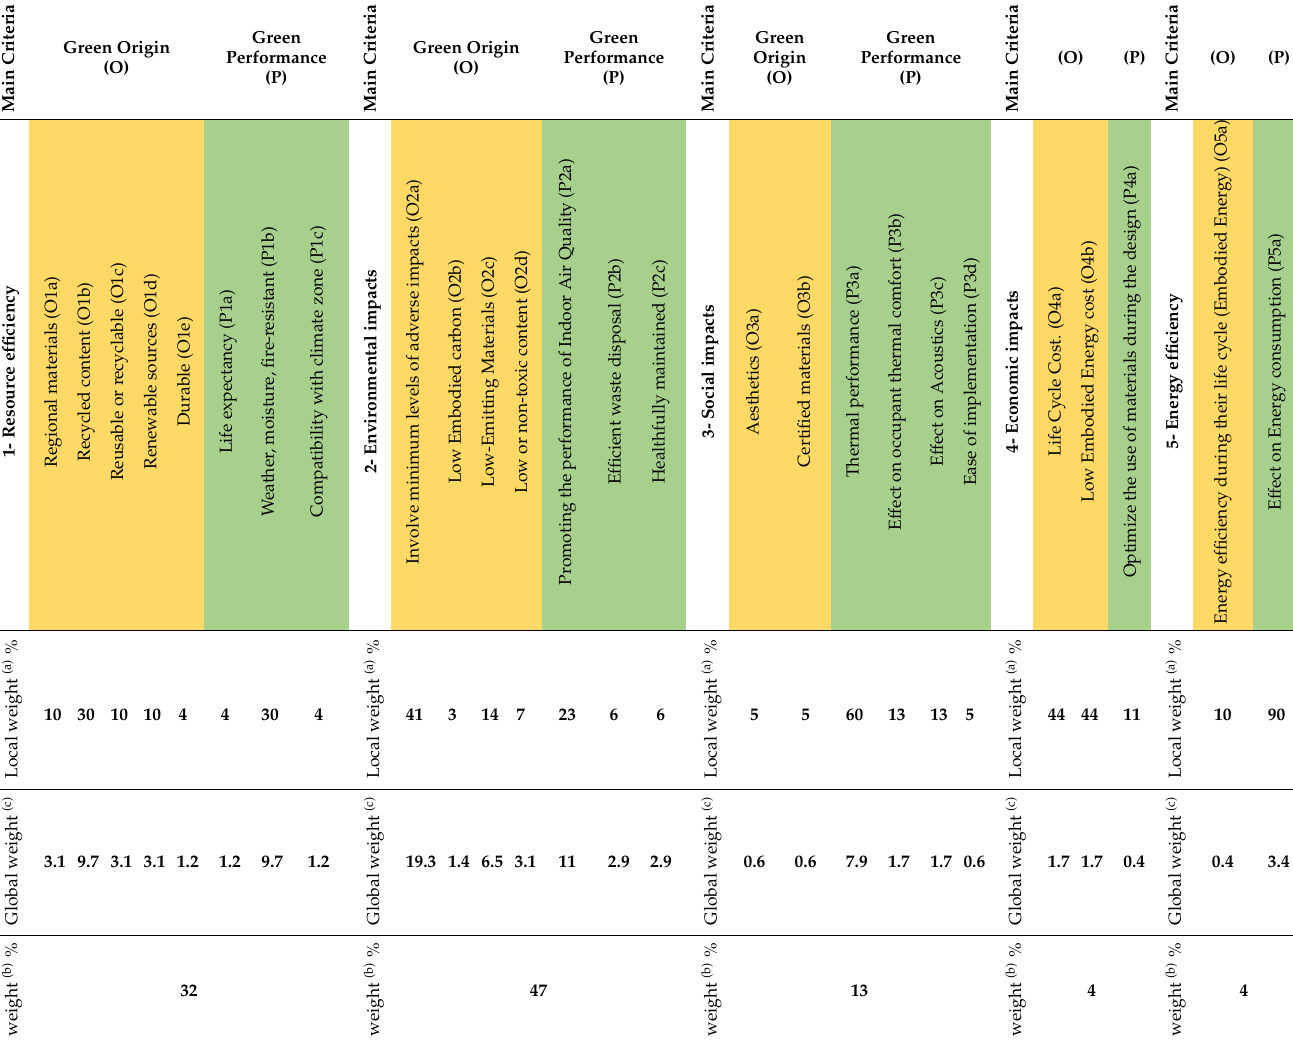
Table 7. Overall rating of the assessment